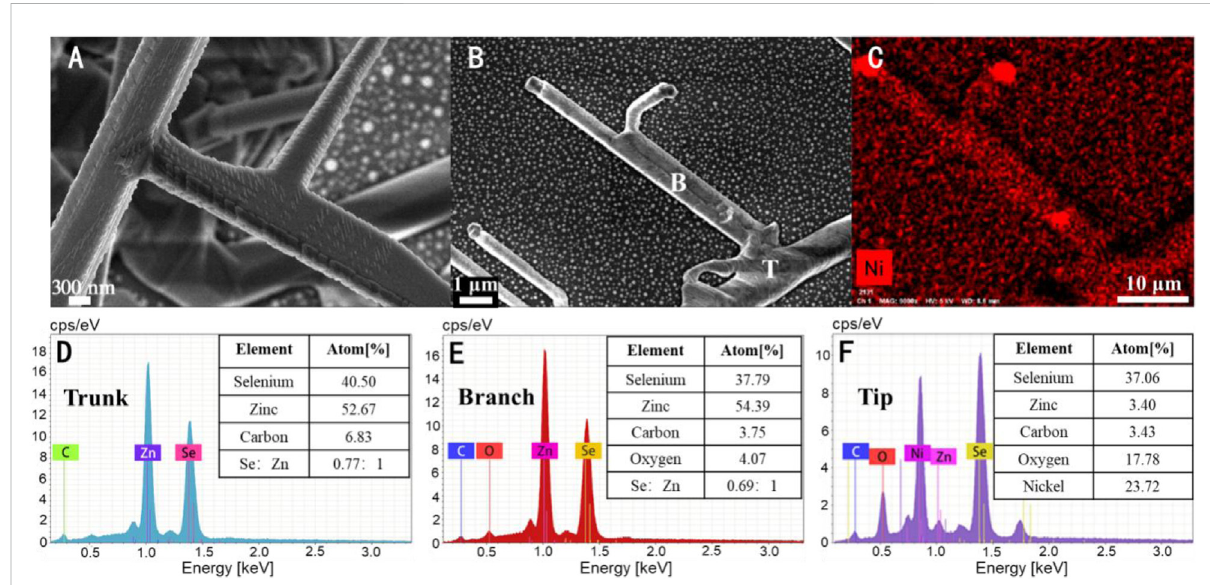
FIGURE 2 (A) SEM image of topological ZnSe nanowires. (C) EDS mapping scan of the image (B) . (D – F) Spectra of EDS scanning on the trunk, topological branch, and top of nanowires, respectively. The table in the upper right corner of each image corresponds to the elements and their proportions in each test position.